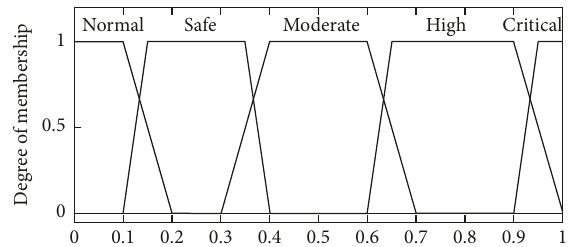
Figure 10: Input variable MF-operational ageing stress factor (OASF).